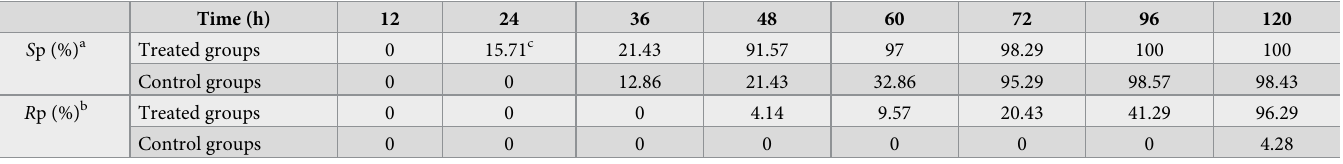
Table 1. Transformation of U . prolifera from vegetative cells into germ cell sac and their release rate. Time (h) 12 24 36 48 120 S p (%) a Treated groups 0 R p (%) b Treated groups Control